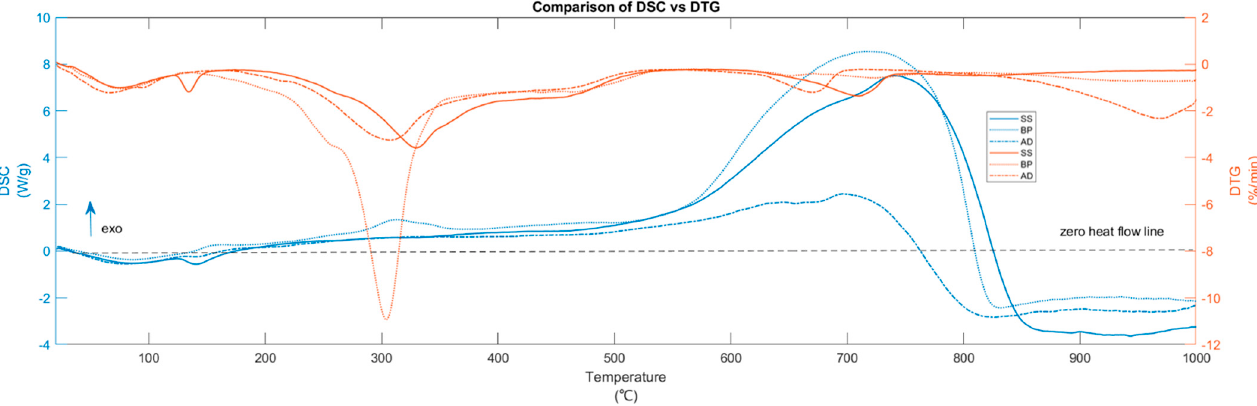
Figure 1. TG–DTG curves during the pyrolysis (at 15 ℃ /min) of BP, SS, and AD.